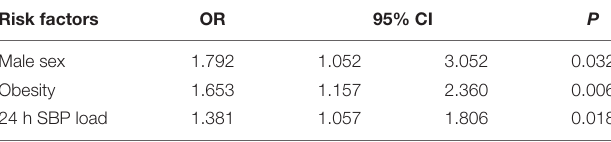
TABLE 6 | Independent risk factors for left ventricular